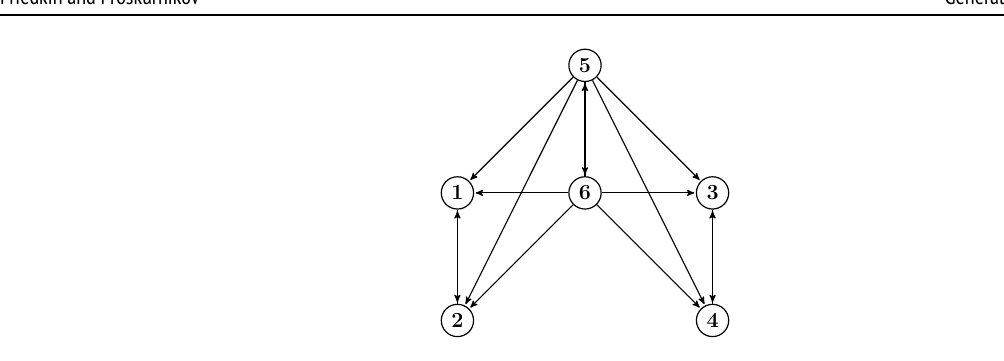
> 0 loops are not ii